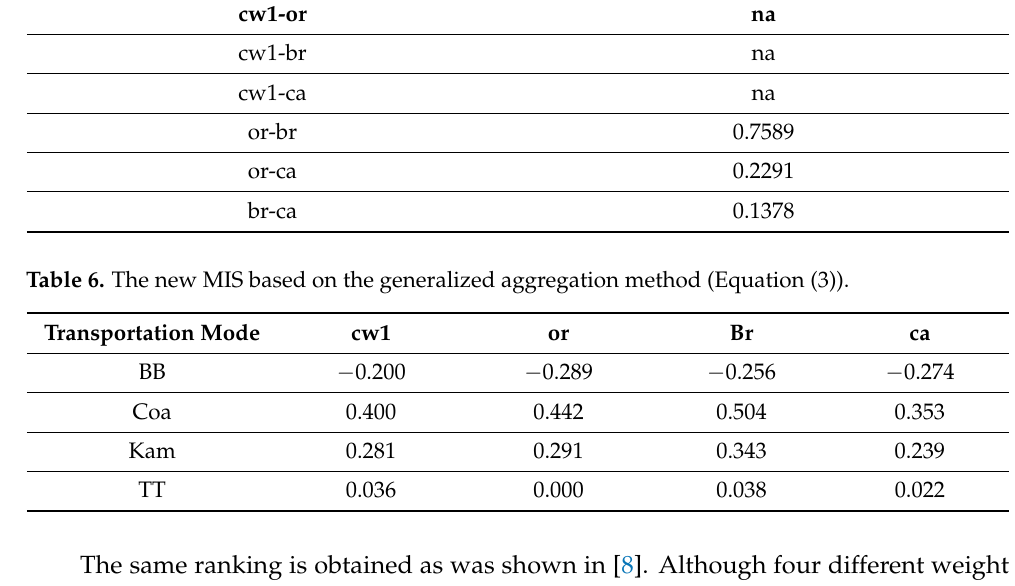
Table 5. Pearson correlation coefficients between the four weight-regimes. cw1-or na cw1-br